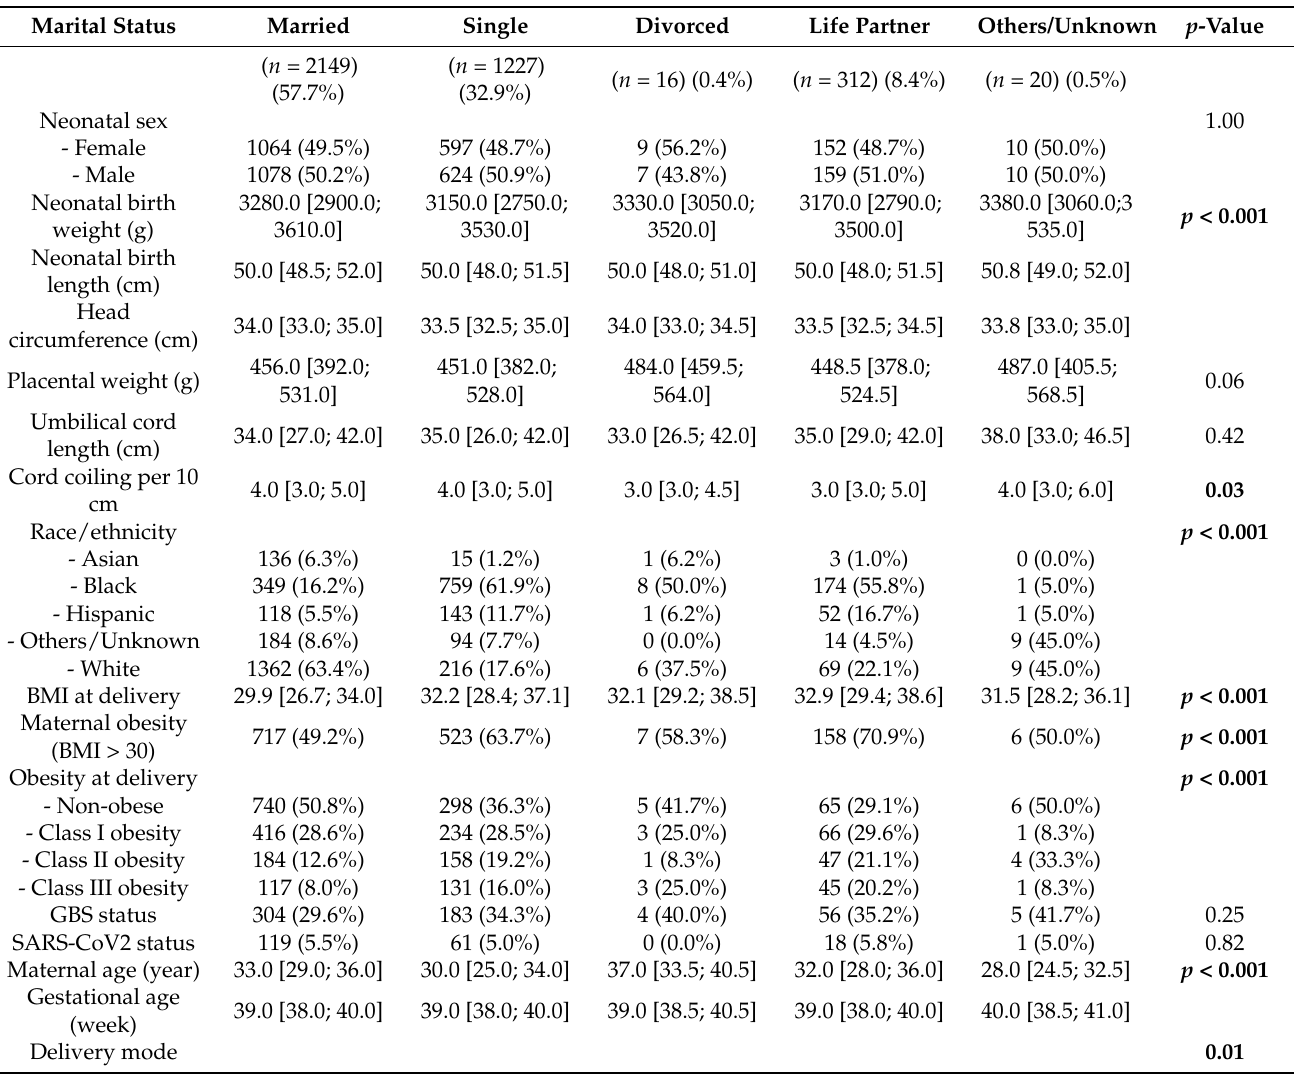
Table 1. Marital status and pregnancy